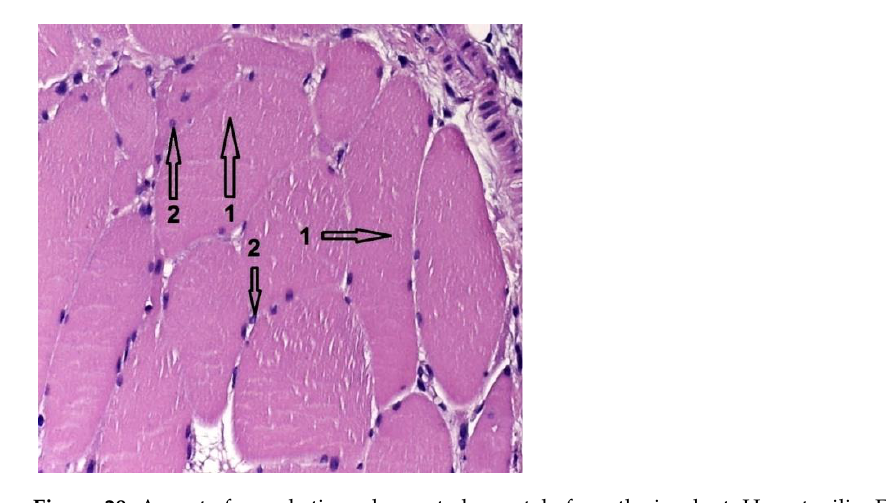
23 of 28 Figure 28. Synovial membrane, H-E stain, 10 × 10. 1-Hydrogen bubbles, 2-Normal synoviocytes, 3- Limited areas of inflammatory tissue, 4-Normal blood vessels. For comparison, we also performed histological examinations on samples from the